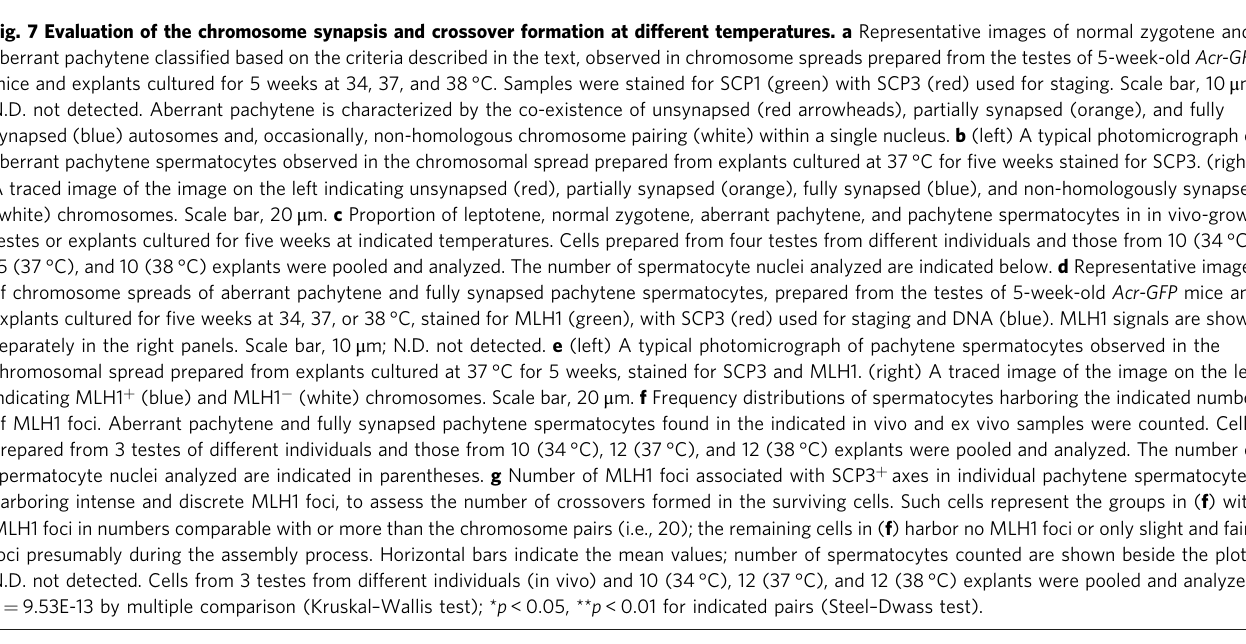
Fig. 7 Evaluation of the chromosome synapsis and crossover formation at different temperatures. a Representative images of normal zygotene and aberrant pachytene classi fi ed based on the criteria described in the text, observed in chromosome spreads prepared from the testes of 5-week-old Acr-GFP mice and explants cultured for 5 weeks at 34, 37, and 38 °C. Samples were stained for SCP1 (green) with SCP3 (red) used for staging. Scale bar, 10 μ m. N.D. not detected. Aberrant pachytene is characterized by the co-existence of unsynapsed (red arrowheads), partially synapsed (orange), and fully synapsed (blue) autosomes and, occasionally, non-homologous chromosome pairing (white) within a single nucleus. b (left) A typical photomicrograph of aberrant pachytene spermatocytes observed in the chromosomal spread prepared from explants cultured at 37 °C for fi ve weeks stained for SCP3. (right) A traced image of the image on the left indicating unsynapsed (red), partially synapsed (orange), fully synapsed (blue), and non-homologously synapsed (white) chromosomes. Scale bar, 20 μ m. c Proportion of leptotene, normal zygotene, aberrant pachytene, and pachytene spermatocytes in in vivo-grown testes or explants cultured for fi ve weeks at indicated temperatures. Cells prepared from four testes from different individuals and those from 10 (34 °C), 15 (37 °C), and 10 (38 °C) explants were pooled and analyzed. The number of spermatocyte nuclei analyzed are indicated below. d Representative images of chromosome spreads of aberrant pachytene and fully synapsed pachytene spermatocytes, prepared from the testes of 5-week-old Acr-GFP mice and explants cultured for fi ve weeks at 34, 37, or 38 °C, stained for MLH1 (green), with SCP3 (red) used for staging and DNA (blue). MLH1 signals are shown separately in the right panels. Scale bar, 10 μ m; N.D. not detected. e (left) A typical photomicrograph of pachytene spermatocytes observed in the chromosomal spread prepared from explants cultured at 37 °C for 5 weeks, stained for SCP3 and MLH1. (right) A traced image of the image on the left indicating MLH1 + (blue) and MLH1 − (white) chromosomes. Scale bar, 20 μ m. f Frequency distributions of spermatocytes harboring the indicated number prepared from 3 testes of different individuals and those from 10 (34 °C), 12 (37 °C), and 12 (38 °C) explants were pooled and analyzed. The number of spermatocyte nuclei analyzed are indicated in parentheses. g Number of MLH1 foci associated with SCP3 + axes in individual pachytene spermatocytes harboring intense and discrete MLH1 foci, to assess the number of crossovers formed in the surviving cells. Such cells represent the groups in ( f ) with MLH1 foci in numbers comparable with or more than the chromosome pairs (i.e., 20); the remaining cells in ( f ) harbor no MLH1 foci or only slight and faint foci presumably during the assembly process. Horizontal bars indicate the mean values; number of spermatocytes counted are shown beside the plots; N.D. not detected. Cells from 3 testes from different individuals (in vivo) and 10 (34 °C), 12 (37 °C), and 12 (38 °C) explants were pooled and analyzed. p = 9.53E-13 by multiple comparison (Kruskal – Wallis test); * p < 0.05, ** p < 0.01 for indicated pairs (Steel – Dwass